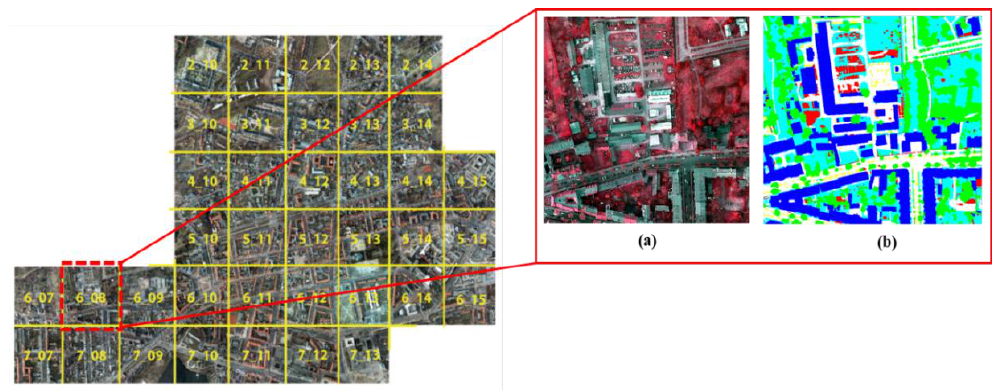
Figure 3. Example of the International Society for Photogrammetry and Remote Sensing (ISPRS) dataset with patch number of 6 – 8: (a) color-infrared image and (b) ground truth map. The classes involve impervious surface (white), buildings (blue), low vegetation (cyan), trees (green), and cars (yellow). Table 1. The patch numbers of labeled data utilized for the ISPRS dataset.